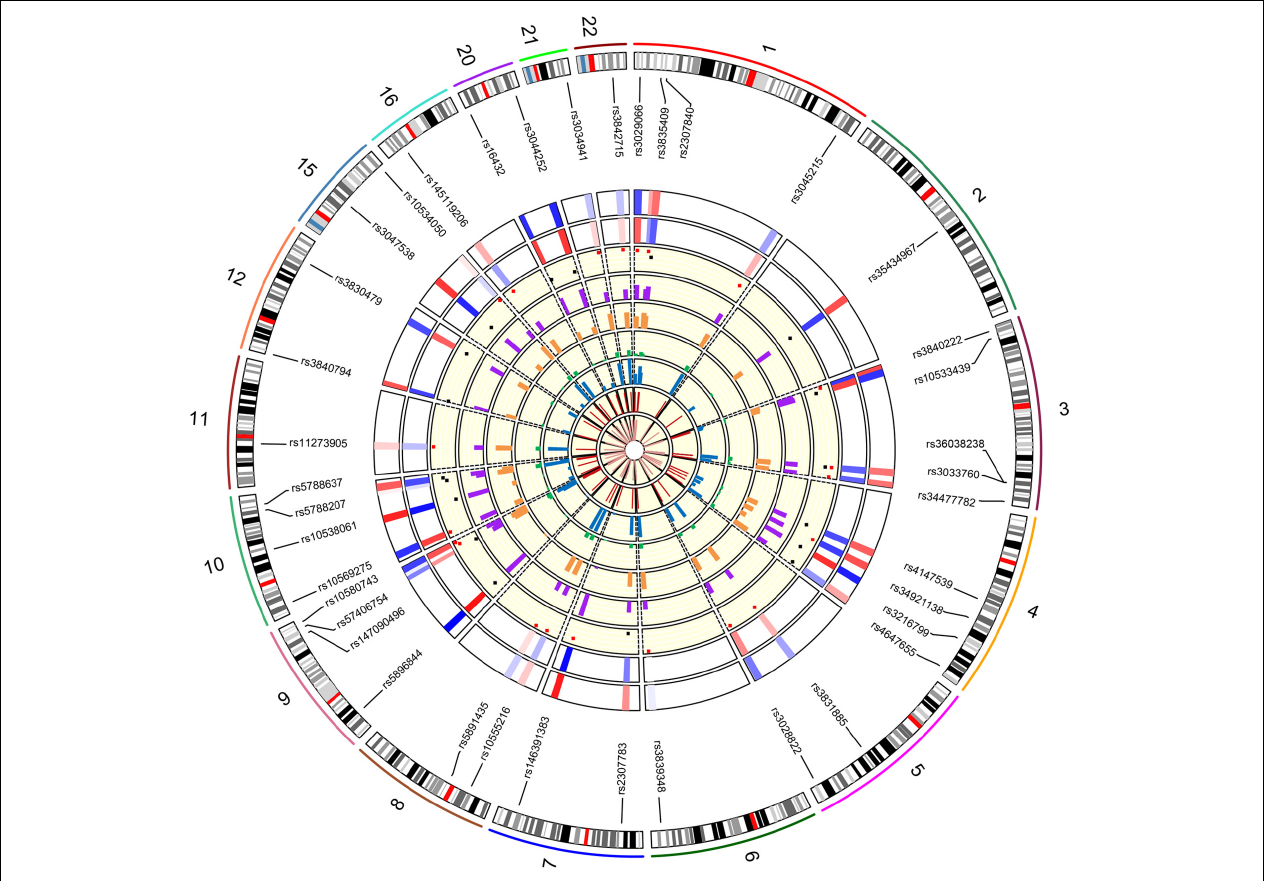
FIGURE 1 | The circle diagram of the chromosome distribution positions, allele frequencies and forensic parameters of the 39 AIDIPs in the Beijing Han population. The inner circles from the outside to the inside represented insertion allele frequencies, deletion allele frequencies, PIC, MP, PD, PE, and TPI, He and Ho values,